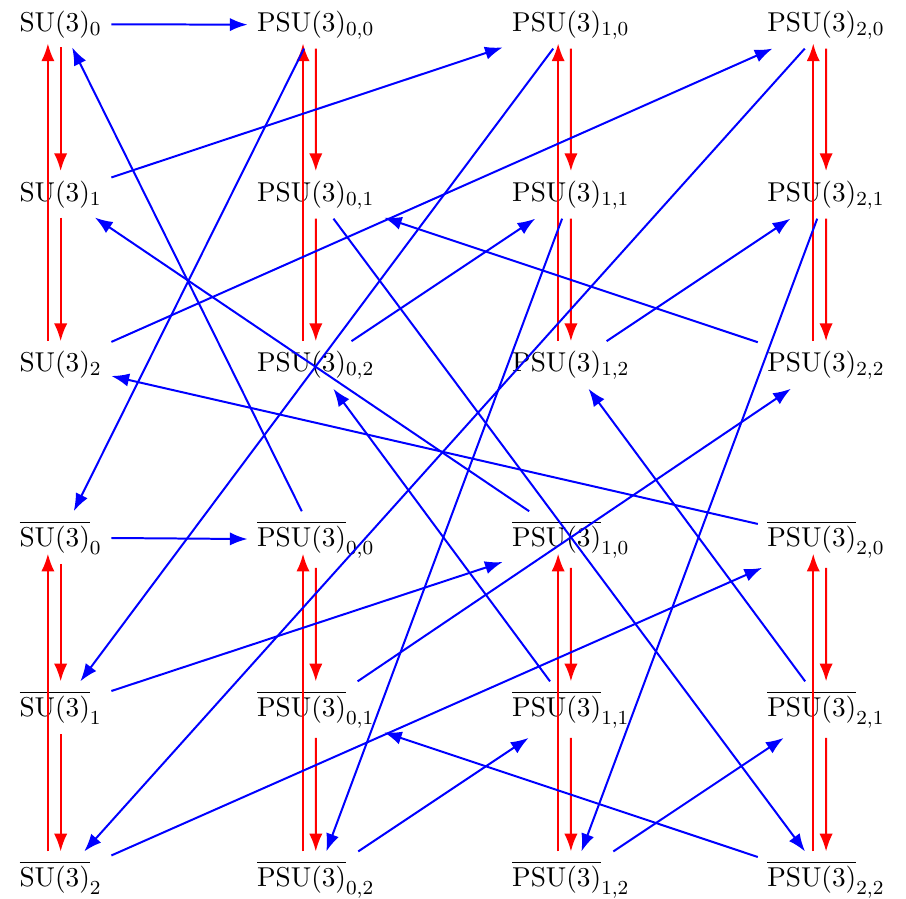
Figure 6 . Web of SL(2 , Z 3 ) transformations for theories with gauge algebra su (3) . We have denoted the action of σ in blue and the action of τ in red, where σ and τ represent gauging the Z (1) and coupling to an invertible phase,